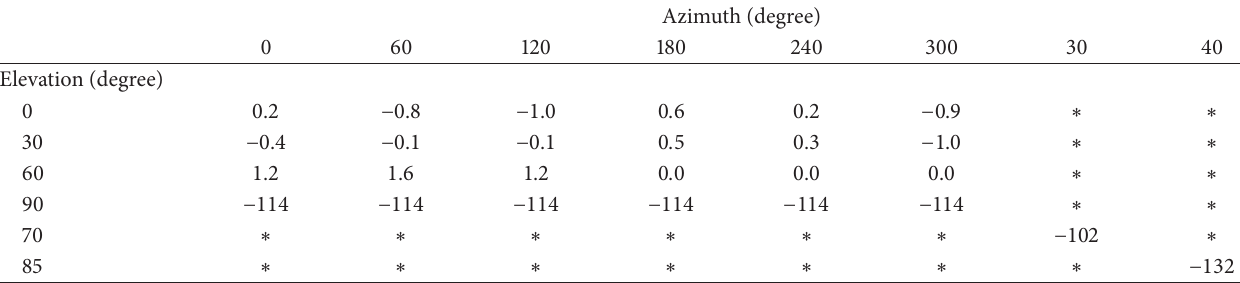
Table 4: Changing interference placement: overall measurement errors (in metres) ( Δ𝜌 𝑝 𝑉 ).